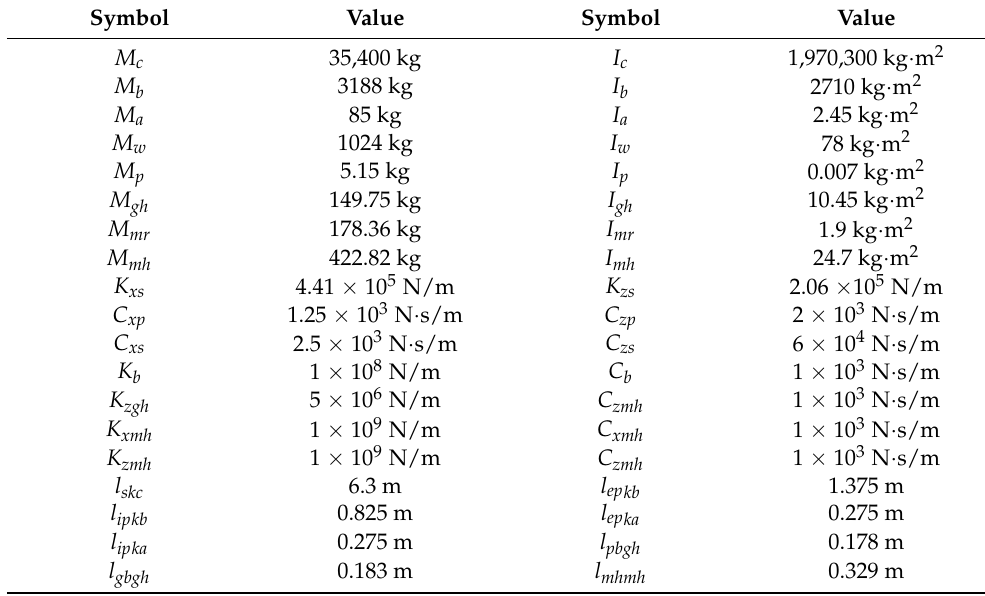
Table 1. Railway vehicle parameters.